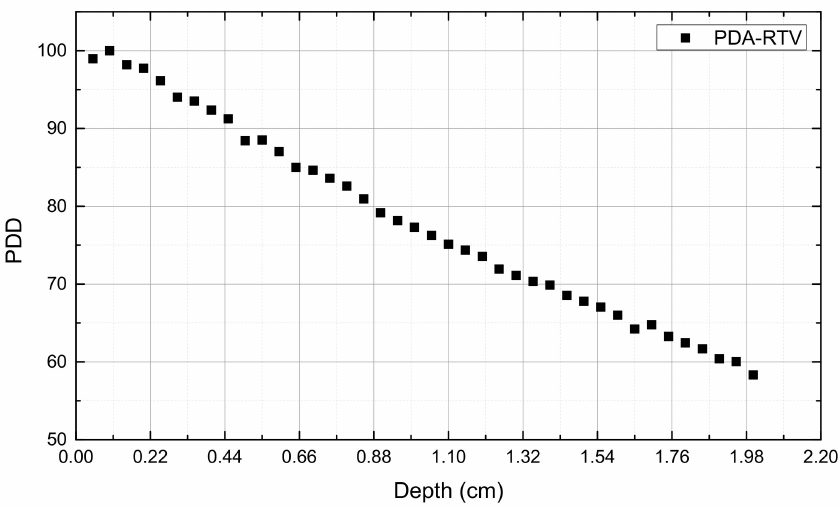
Figure 9. The simulation results for the PDD curve of the PDA-RTV dosimeter.